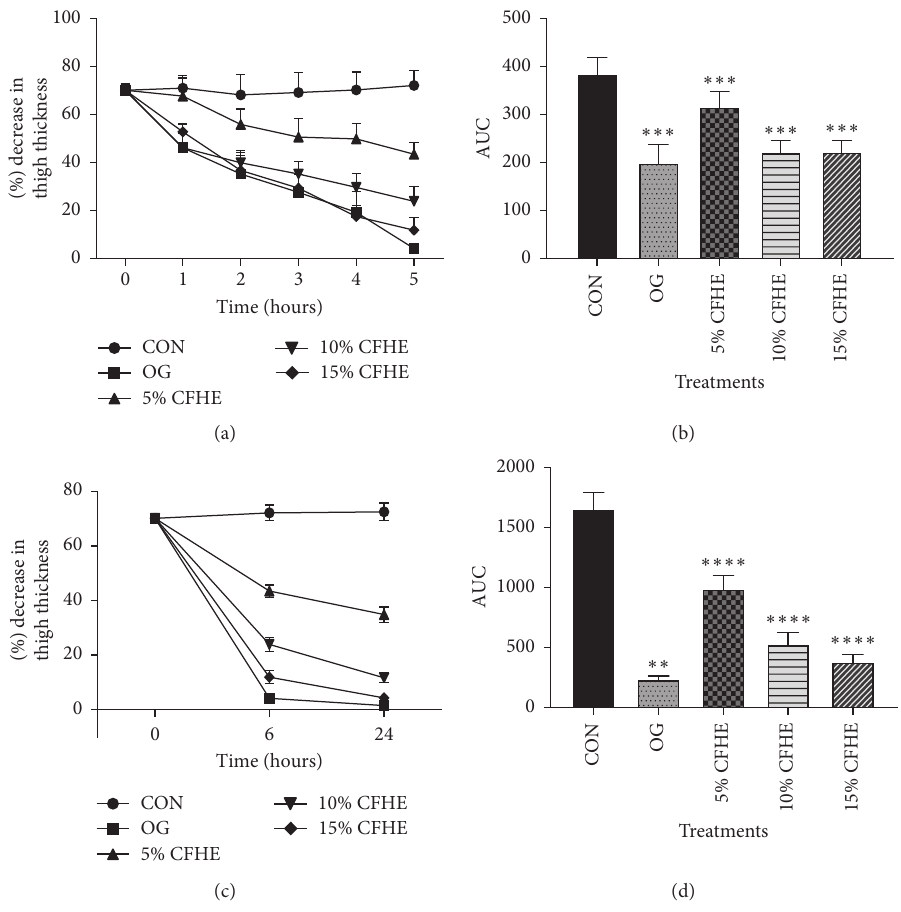
Figure 5: (a) The time-course curves for the effect of 5, 10, and 15% CFHE ointment and olfen gel (OG) on thigh edema in 7-day-old cockerels for 1–5 hours of treatment, (b) AUC for time-course curves in (a), (c) the time-course effects for effect of 5, 10 and 15% CFHE and 1% Diclofenac ointments on thigh edema in 7-day-old cockerels for 6 and 24 hours of treatment, and (d) AUC for time-course curves in (c); values are means ± SEM ( n � 5). ∗∗ p ≤ 0 . 01, ∗∗∗ p ≤ 0 . 01 , comparing treatments versus control (CON); one-way ANOVA followed by Dunnett’s multiple comparisons test.